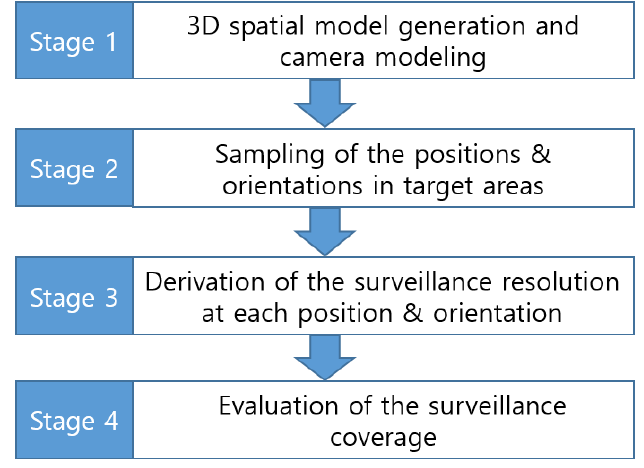
Figure 3. Surveillance Coverage Evaluation